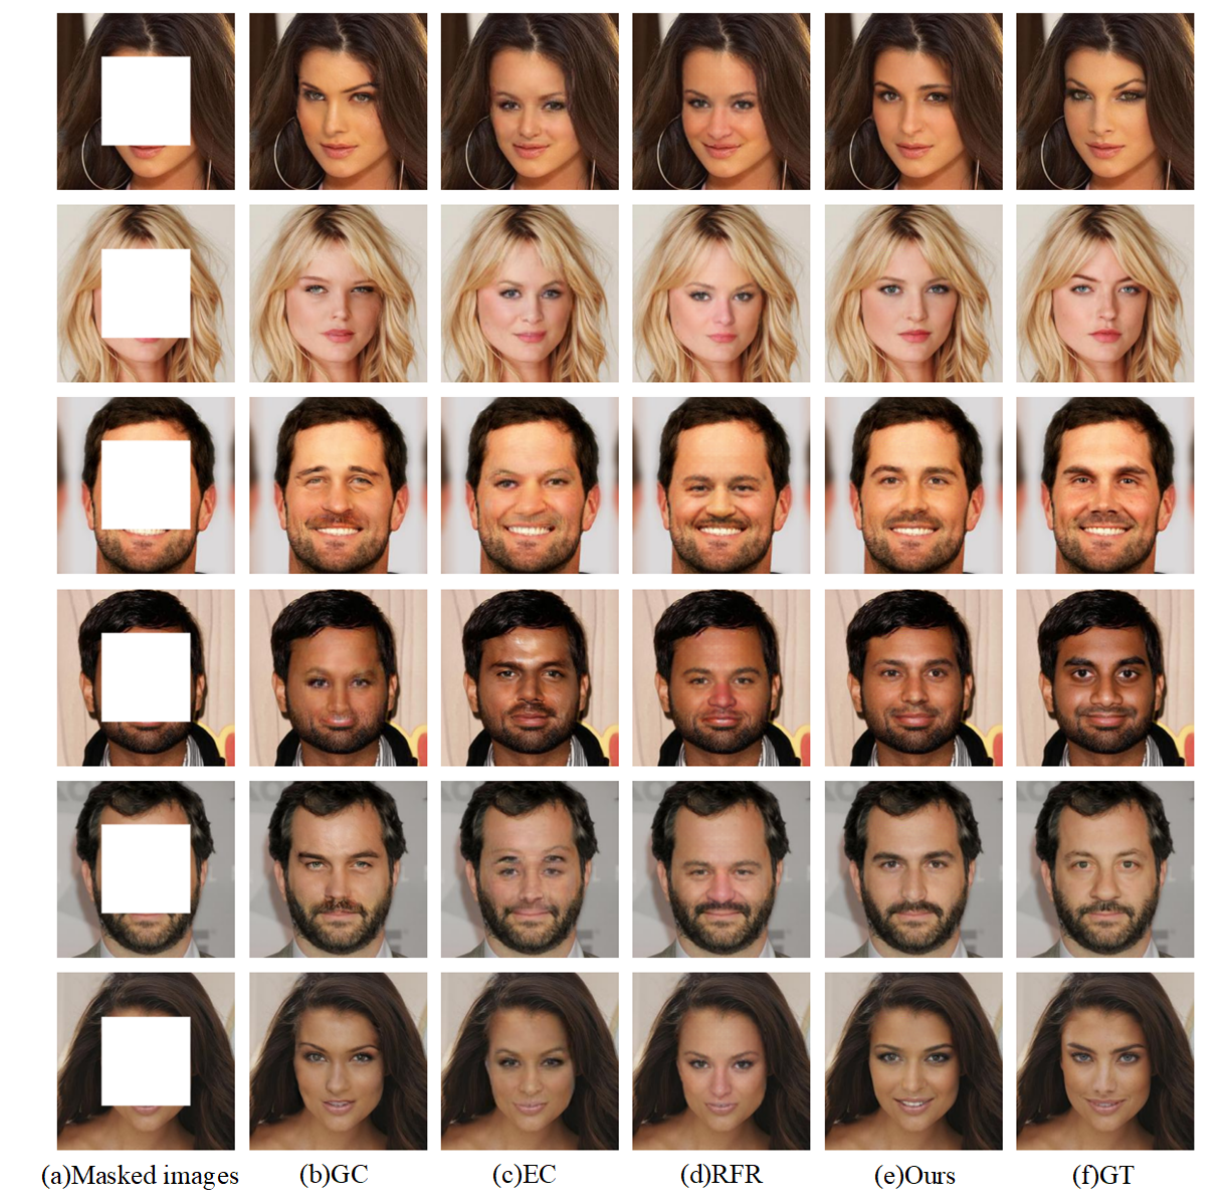
Figure 4. Qualitative comparison results under the center rectangle